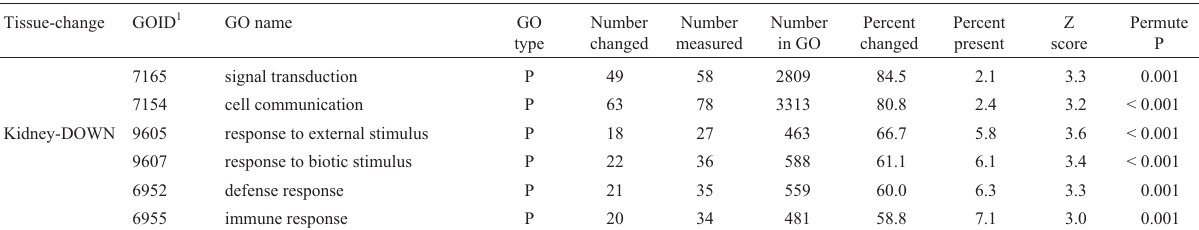
Table 3 (cont.) Tissue-change